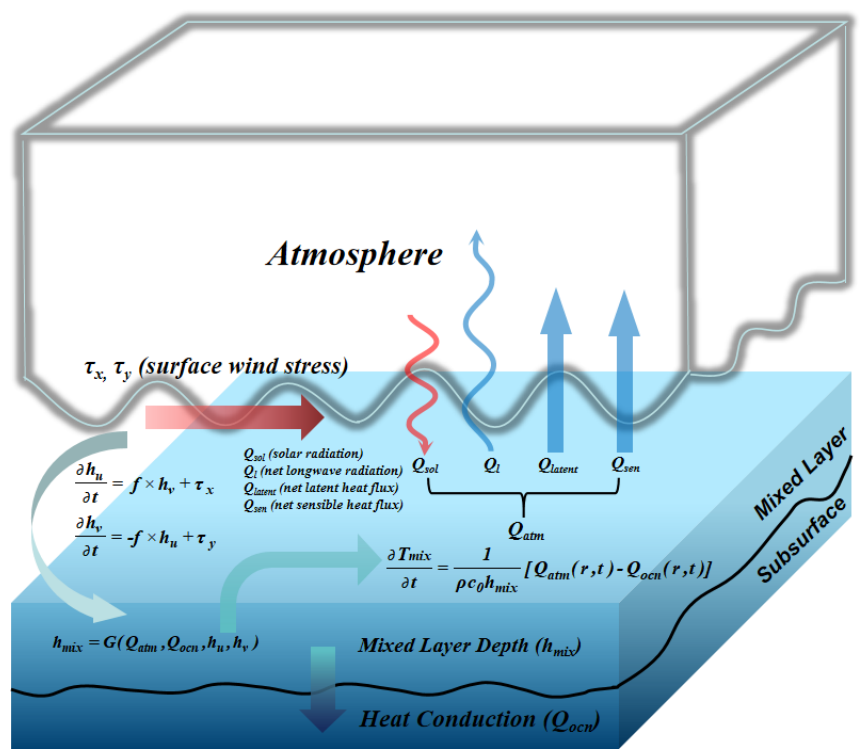
Figure 1. Schematic illustration of a slab ocean model (SOM) coupled to the Weather Research and Forecasting model (WRF). τ x and τ y are the zonal and meridional component of wind stress at the surface, respectively. h u ( h v ) is the τ x -driven ( τ y -driven) momentum in the ocean mixed layer, f is Coriolis force, C 0 is the specific heat capacity of the ocean water, and h mix is the mixed layer